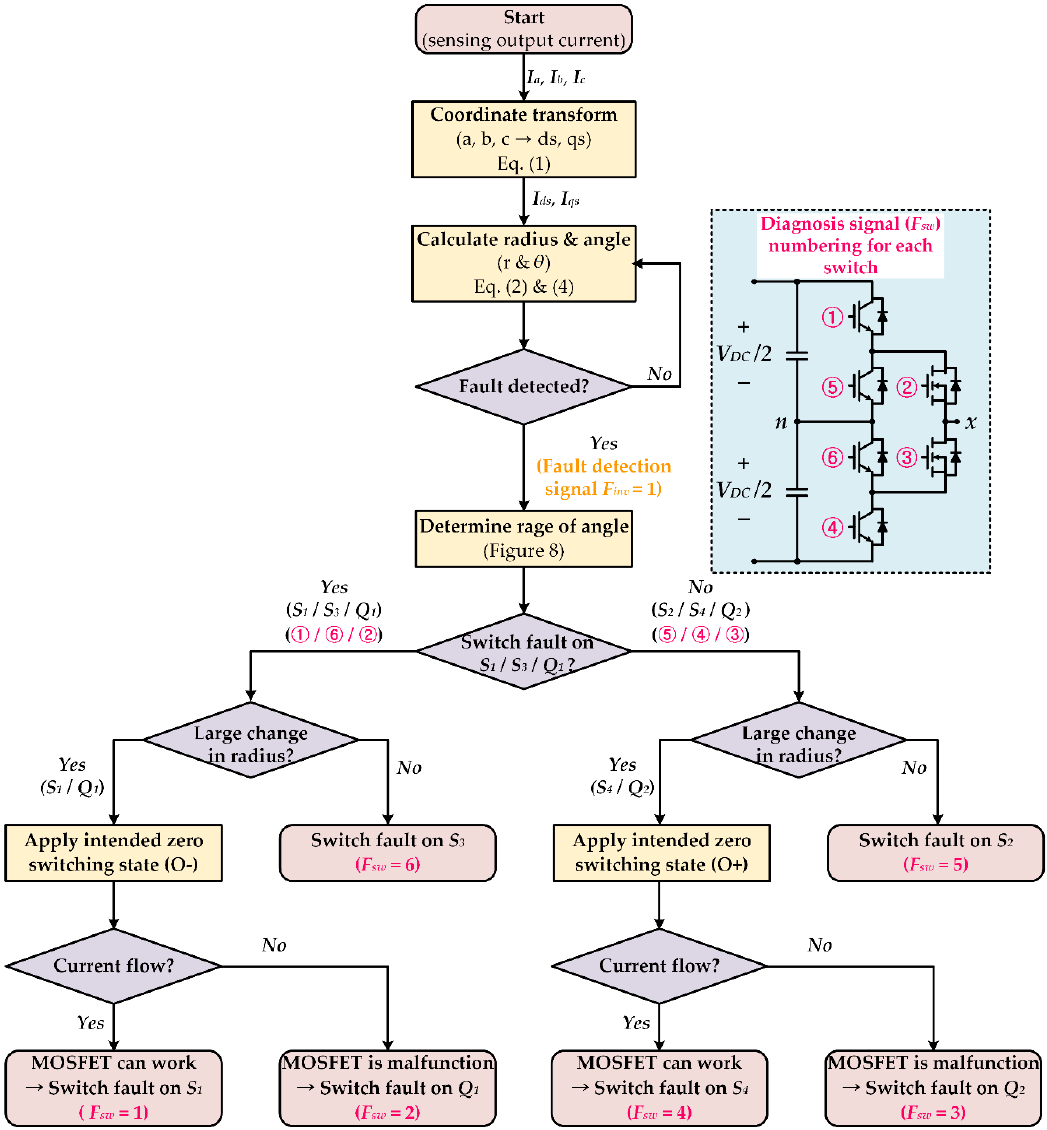
Figure 10. Flowchart of the proposed fault diagnostic method for open-switch failure in the HANPC inverter.